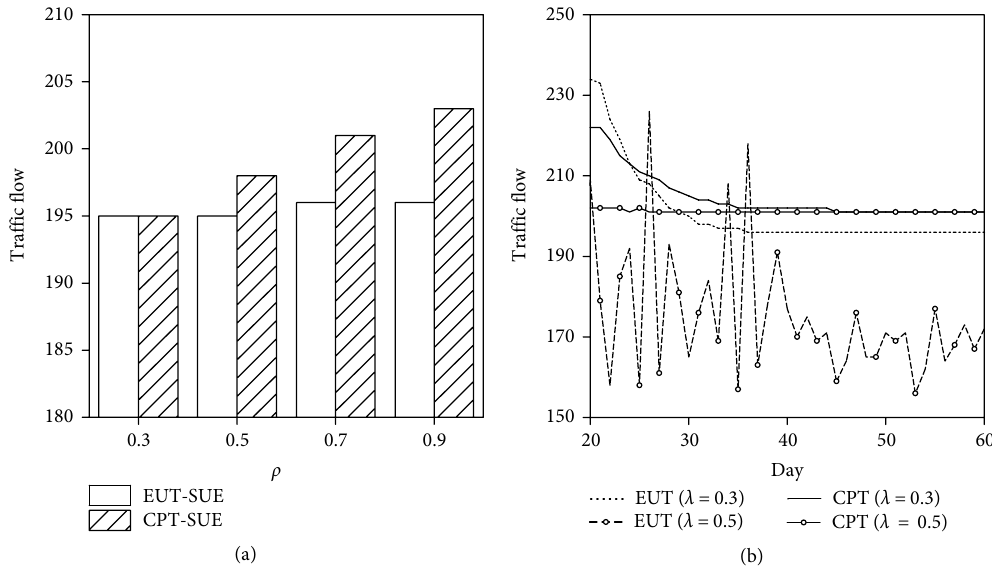
Figure 5: Evolutionary systems under EUT and CPT. (a) Equilibrium state. (b) Sensitivity to parameter λ